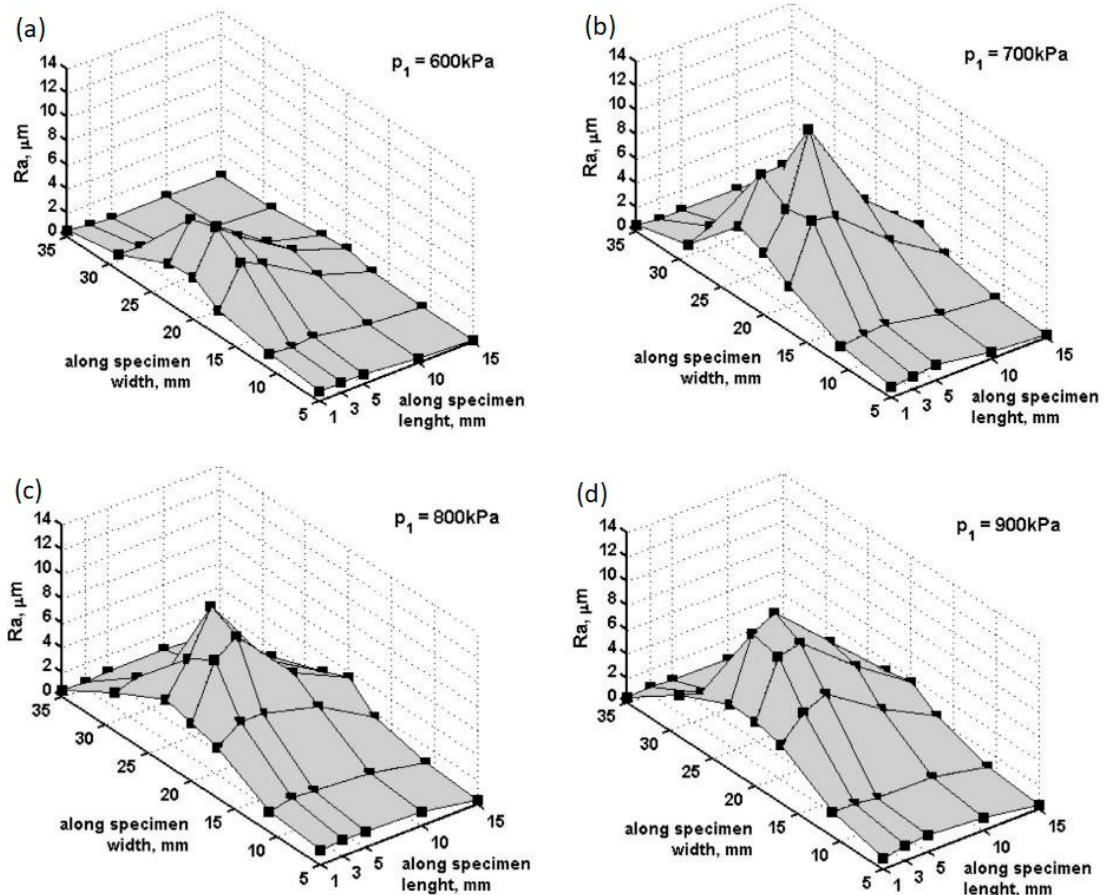
Figure 5. Profile of Ra roughness parameter of 316L steel exposed to cavitation at: ( a ) p 1 = 600 kPa; ( b ) p 1 = 700 kPa; ( c ) p 1 = 800 kPa; ( d ) p 1 = 900 kPa (marked points show the arithmetic mean calculated from the values of experimental data) [17] (Reprinted from “Effect of cavitation intensity on degradation of X6CrNiTi18-10 stainless steel” by A.K. Krella,